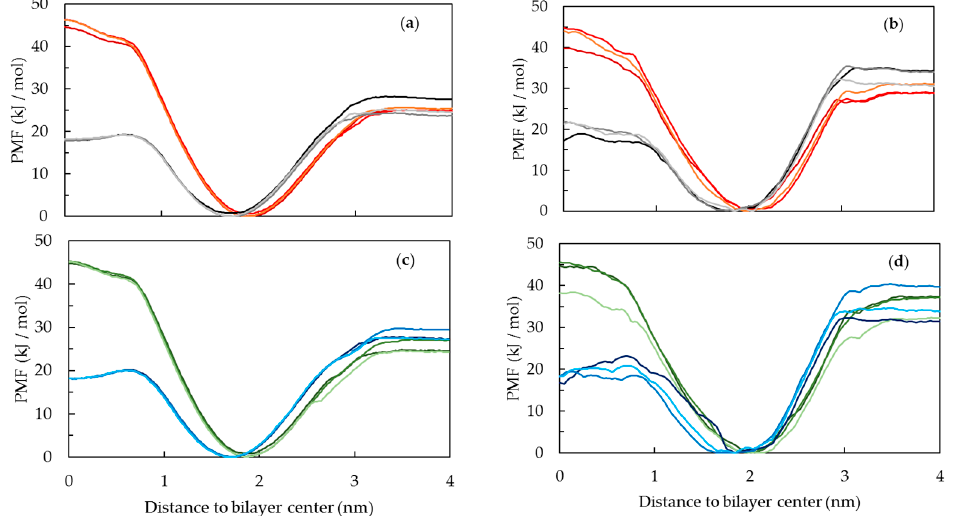
Figure 11. Potential of mean force (PMF) profiles across the lipid bilayers of c -PnA in POPC ( a ), c -PnA in DPPC ( b ), t -PnA in POPC ( c ) and t -PnA in DPPC ( d ). Data are presented with the following color code: ionized c -PnA (red), neutral c -PnA (black/gray), ionized t -PnA (green) and neutral t -PnA (blue). Curves with different shades of these colors correspond to profiles obtained from replicate sets of umbrella sampling simulations.